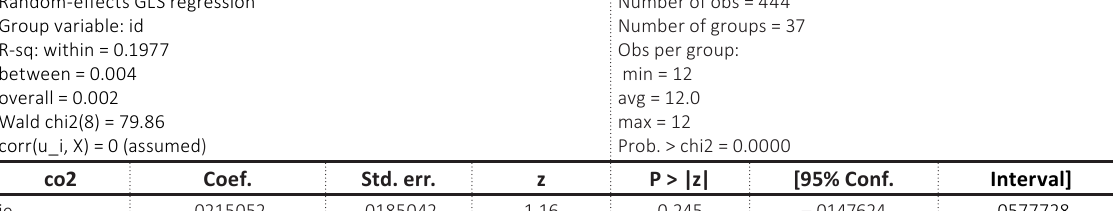
Table 2. Impact of digital factors on CO2 emissions per capita Random-effects GLS regression Group variable: id R-sq: within = 0.1977 between =